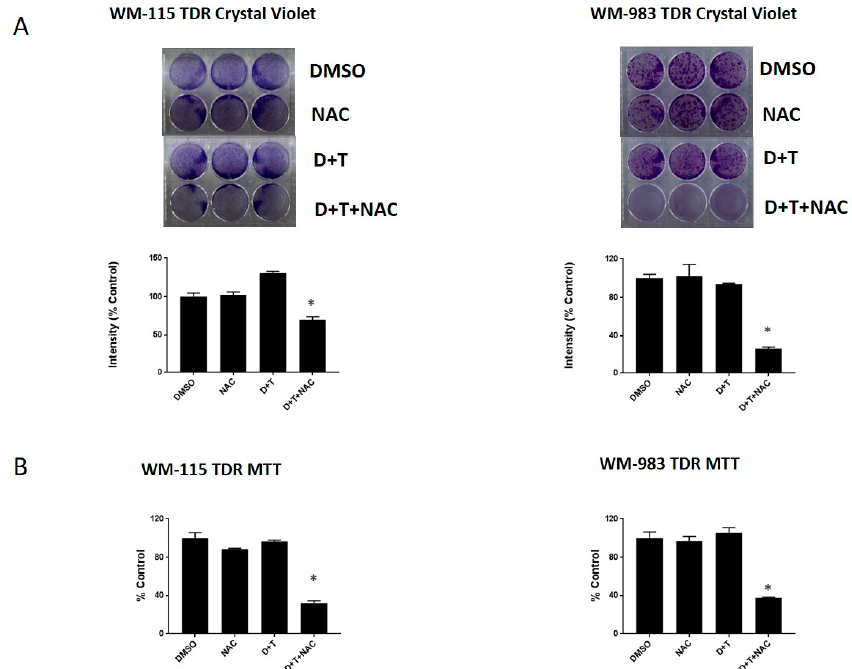
Figure 6. N-Acetyl Cysteine (NAC), a ROS scavenger, can re-sensitize BRAF pathway inhibitor-resistant melanoma cells. ( A ) WM-115 TDR and WM-983 TDR cells (30,000 cells / well) were plated in triplicate and treated with DMSO, 5 mM N-Acetyl Cysteine (NAC), and / or 2.4 µ M dabrafenib and 500 nM trametinib, as indicated. ( B ) WM-115 TDR and WM-983 TDR cells were plated in triplicate in 96 well plates and treated for 72 h with DMSO, 5 mM NAC, and/or 2.4 μ M dabrafenib and 500 nM trametinib, as indicated. * p < 0.05 versus DMSO control. Statistical analysis by one way ANOVA.